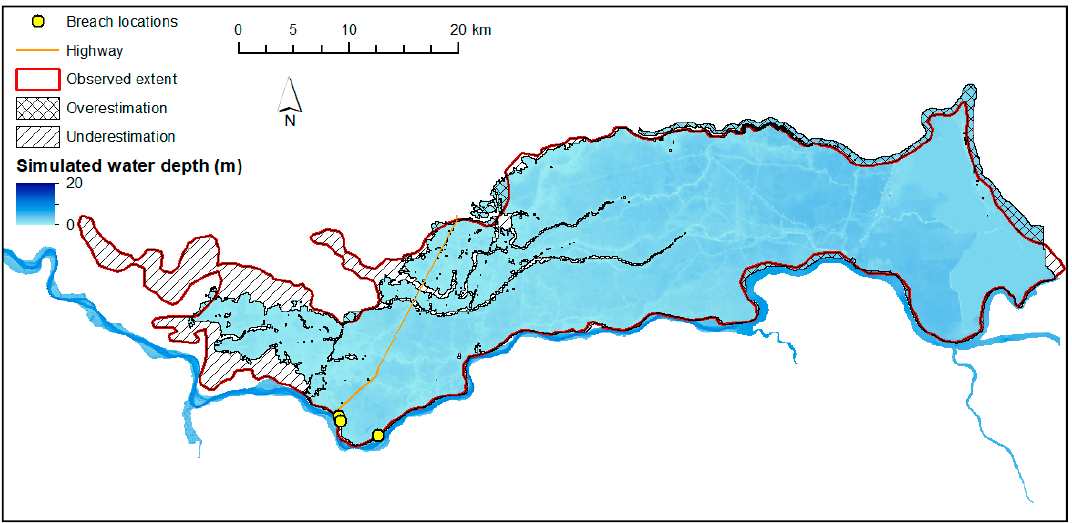
Figure 9. Results of the Polesine flood simulation. Maximum water depth at each cell compared to surveyed flood extent.